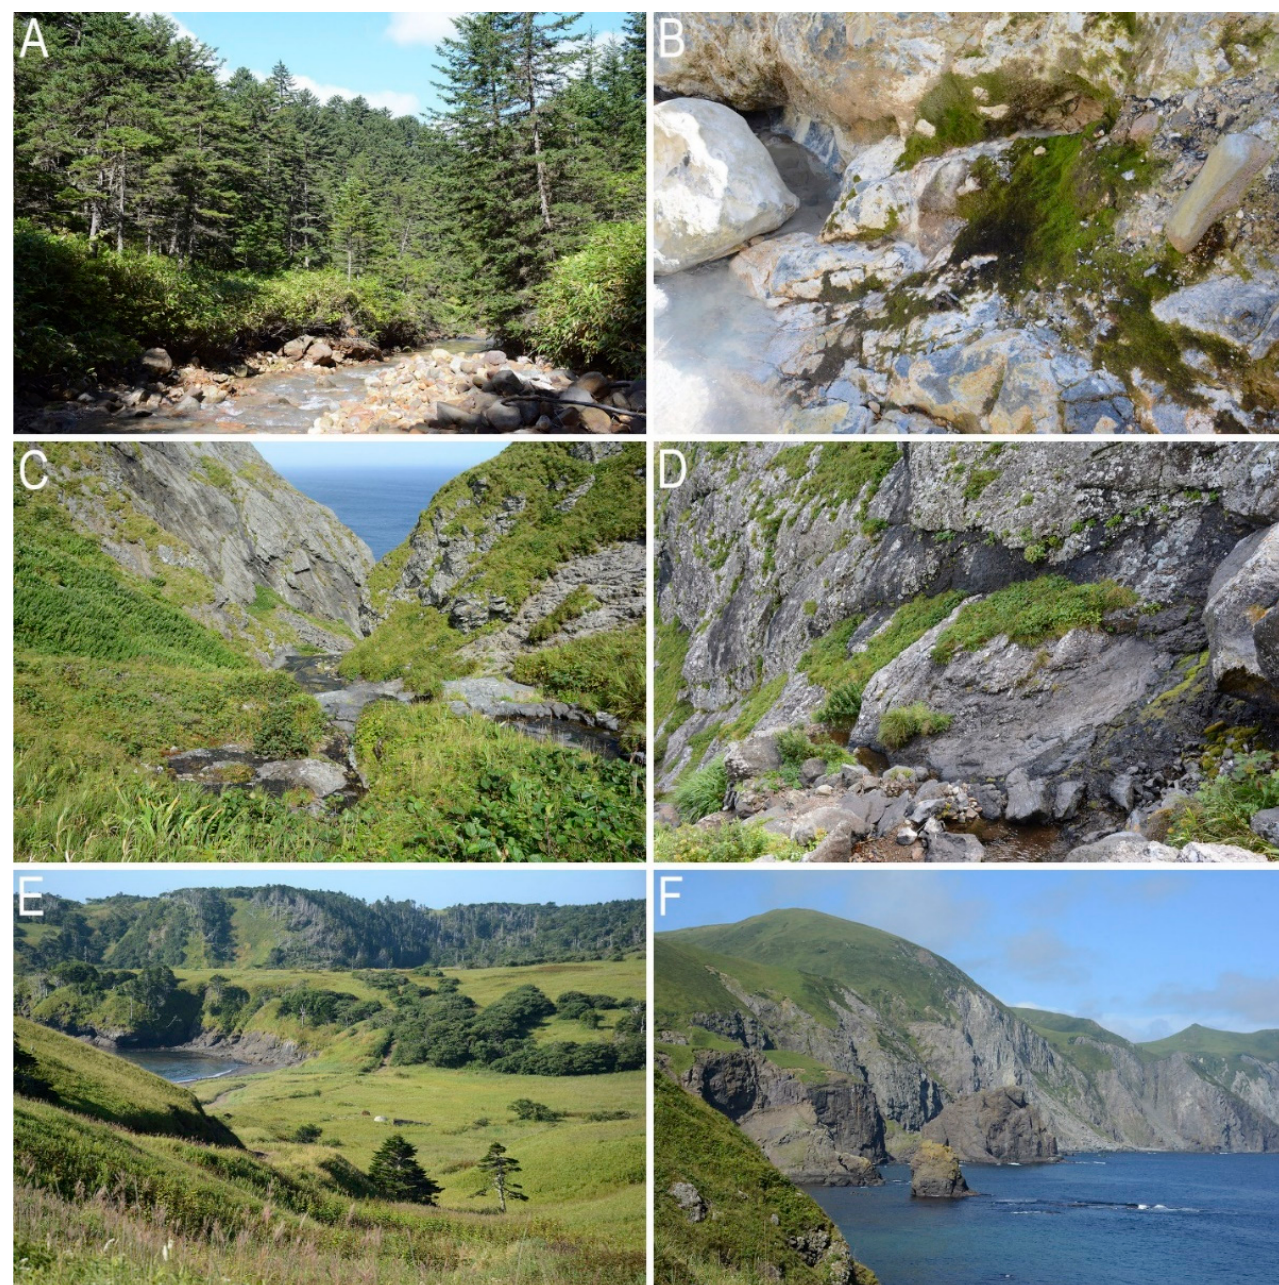
Figure 6. Liverwort habitats on Kunashir and Shikotan Islands: ( A ) Abies nephrolepis forest in Kislaya River valley, foot of Mendeleeva Volcano, Kunashir Island Middle part; ( B ) Metasolenostoma orientale on a bank of Kislaya River, NE-facing slope of Mendeleeva Volcano, middle part of Kunashir Island. (Photo by K.G. Klimova, 2018); ( C ) Scapania gigantea habitat, stream to sea in coastal cliffs, Shikotan Island; ( D ) sea-facing rocks—one of the habitat of Gymnomitrion faurieanum and Radula brunnea , Shikotan Island; ( E ) Krab Cape surroundings, Shikotan Island; ( F ) northeast rocky coast of the island, northward of Krab Cape, Shikotan Island (Photo by K.G. Klimova, 2020).